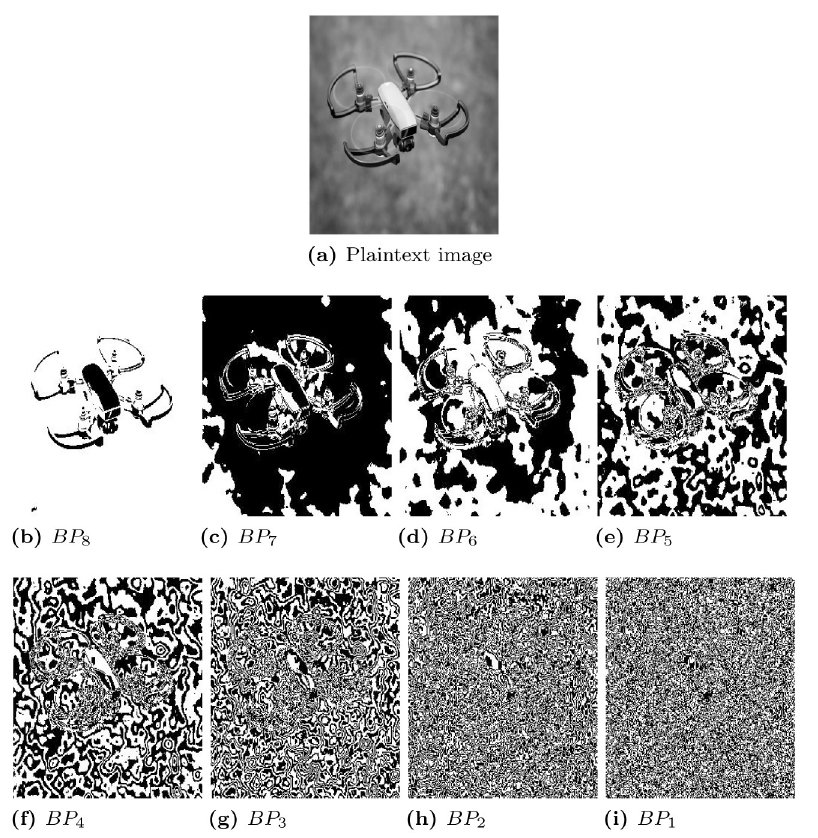
Fig 2. Pliantext image and its corresponding extracted bit-planes. (a) Plaintext image, (b) BP 8 , (c) BP 7 , (d) BP 6 , (e) BP 5 , (f) BP 4 , (g) BP 3 , (h) BP 2 , and (i) BP 1 .